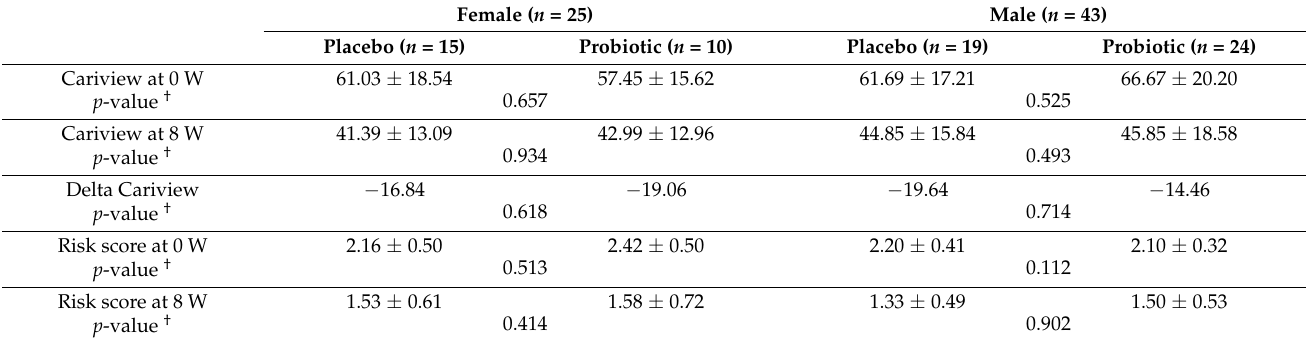
Table 4. Comparison of changes in the Cariview and risk scores according to gender ( n =